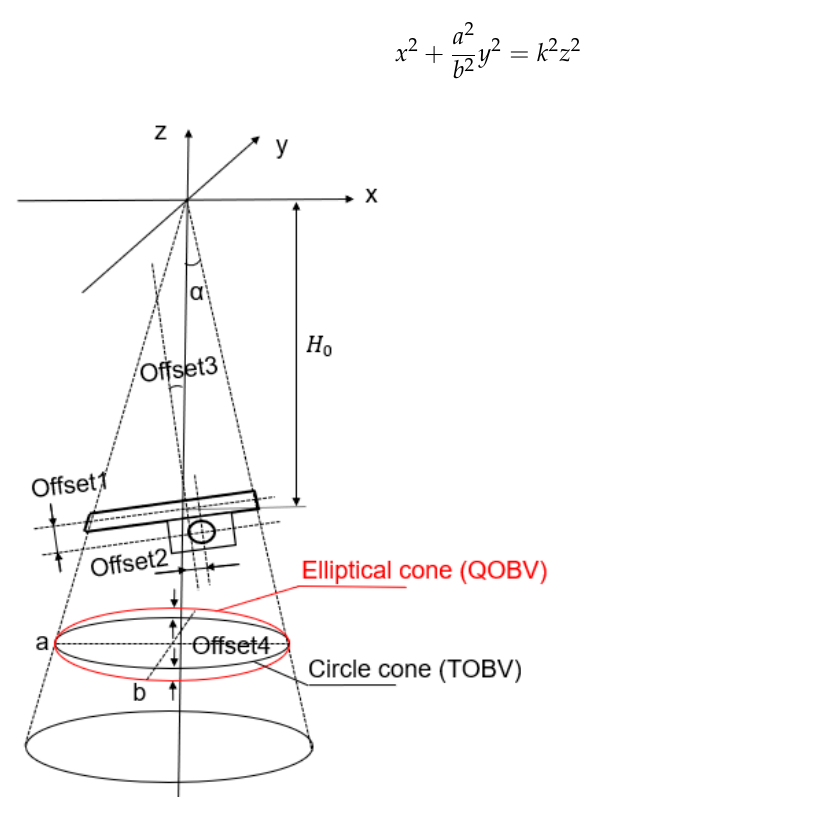
When the ellipse cone function of QOVB and the circular cone function of TOBV overlap in the xz plane (y = 0), as shown in Figure 4, the new ellipse cone function, Equation (3), can be defined by substituting Equation (2) into Equation (1).